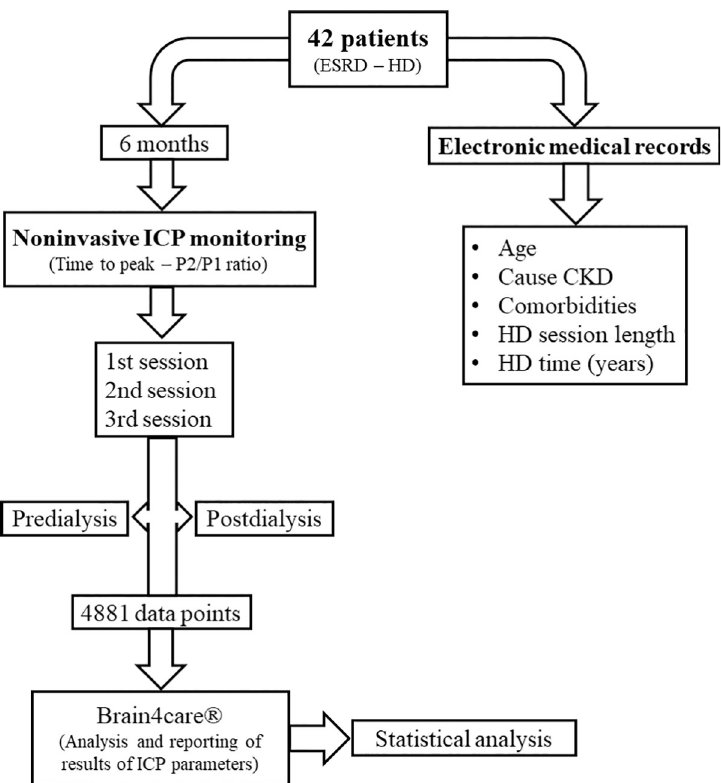
Fig 1. Flowchart of this research. CKD: Chronic kidney disease; ESRD: End-stage renal disease; HD: Hemodialysis; ICP: Intracranial